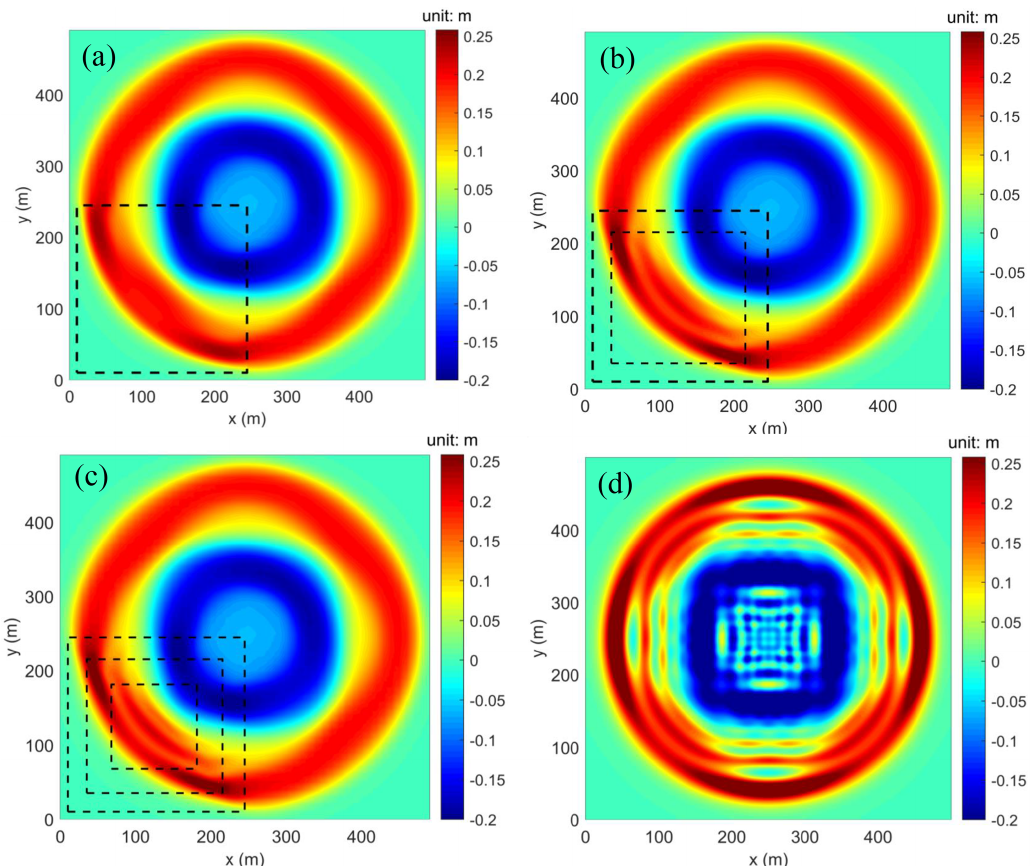
Figure 6. Wave generation from an initial 1m elevation still-water hump. Snapshots of surface elevations computed at t = 23s in (a) two- level grids, (b) three-level grids, and (c) four-level grids, with a discretization of 10, 5, 2.5, and 1.25m, respectively ( s = 2), and (d) a single-level grid with a resolution of 1.25m. Dashed lines denote the boundary of child